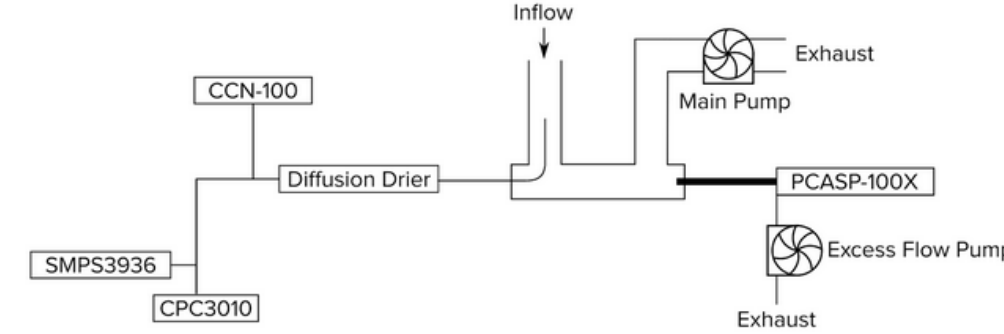
Figure 4. A schematic layout of the particle counting instruments in the aerosol container laboratory (not to scale).